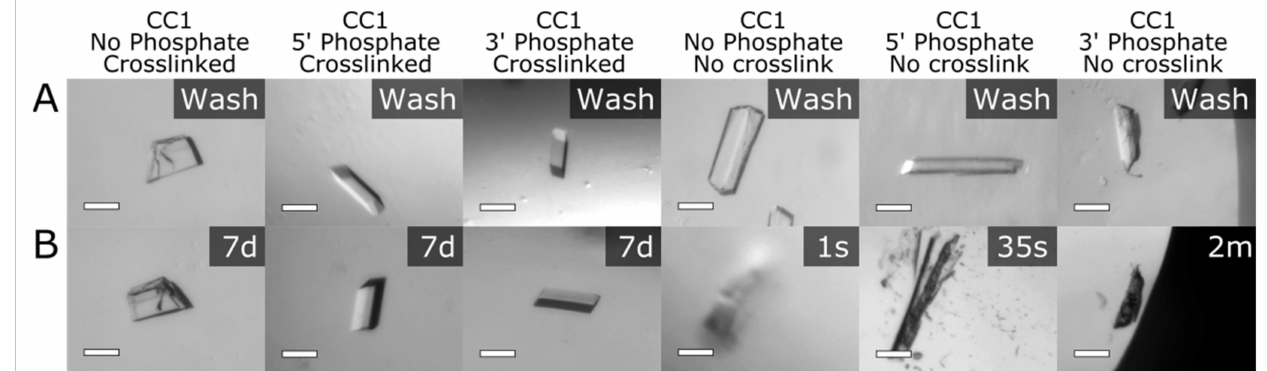
Figure 7. The crystals were crosslinked with 15 mg/mL EDC for 20 h and quenched with Tris base pH 8.2 for 30 min prior to transfer to the wash solution. All scale bars are 100 µ m. ( A ) CC1 crystals in wash solution containing 50 mM NaCl, 14% PEG 400, and 200 mM MES buffer pH 6.0. The concentrations of the wash solution matched the initial crystal growth solutions, but we replaced MgCl 2 with NaCl and Tris HCl pH 8.0 with MES buffer pH 6.0. ( B ) CC1 crystals after transitioning to an ion-free environment (deionized water). The crosslinked crystals (left three panels) remained intact for 7 days. Non-crosslinked control crystals (right three columns) dissolved or converted to an aggregate at various immediate time